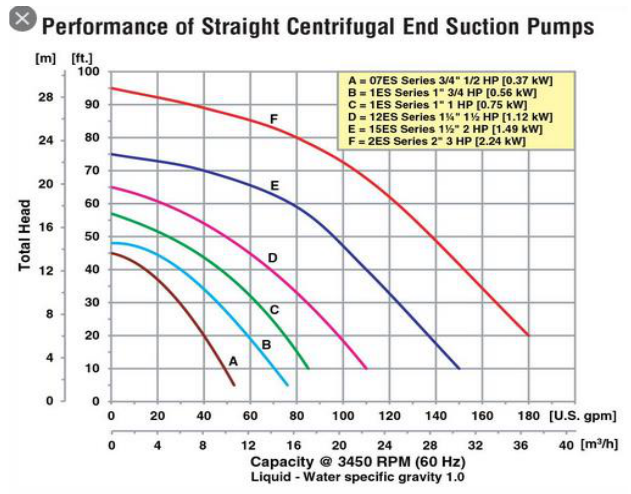
Fig. 2. Pump chart for ES model pump